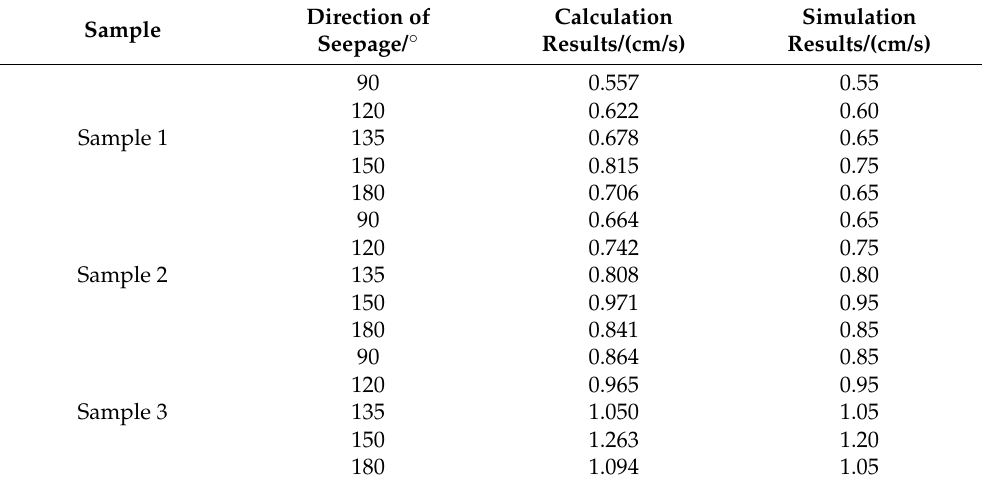
The comparison of the critical velocity obtained from the calculation formula and numerical simulation is shown in Figure 6. If the position of the scatter distribution is closer Table 2. The critical velocity, calculated by formula and numerical simulation under different con- to the diagonal line in the figure, it means that the data are more consistent and the formula ditions. predicts the critical velocity of particle initiation better. As shown in Figure 6, the data points are basically distributed along the contour line, and the mean of the ratio between test and predicted values compared to 1 had a deviation of 0.0268, a covariance (COV) of 0.0344, and a maximum deviation of 6.145%, which is within ± 7%,